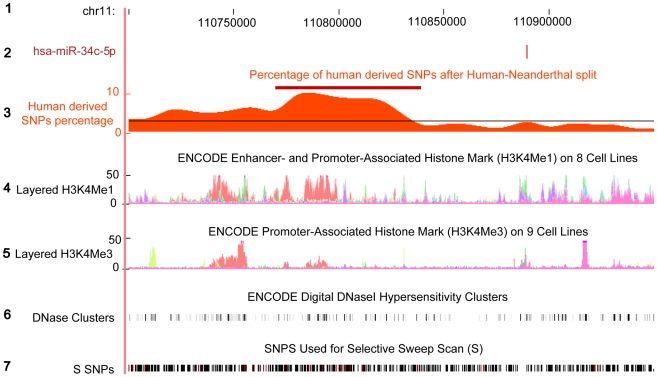
Excess of human derived SNPs in the upstream region of hsa-miR-34c.The plot shows 150kb region upstream of human miR-34c. The region annotation, from top to bottom: (1) The human genome coordinates based on hg18; (2) The genomic location of miR-34c-5p miRNA; (3) The percentage of human derived SNPs out of all SNPs calculated within 50kb sliding windows. The red bar shows the sliding windows with the significant excess of human derived SNPs, compared to the genome average (Fisher's exact test, Bonferroni corrected p<0.05). The average genome percentage is depicted by the black line (Materials and Methods); (4) H3K4Me1 histone modification density in eight cell lines from ENCODE database [66]. Presence of this histone mark indicates enhancer and, to a lesser extent, promoter activity [67]; (5) H3K4Me3 histone modification density in nine cell lines from ENCODE database [66]. Presence of this histone mark is associated with promoters [67]. Note that the genomic region showing the highest density of human derived SNPs overlaps with enhancer activity, but not with the promoter histone modification mark; (6) DNase Hypersensitivity Clusters from ENCODE database [66]. Regulatory regions tend to have higher DNase sensitivity [68]; (7) SNPs used in a genome-wide scan for signals of positive selection in the human lineage since divergence from the Neanderthal lineage [40]. Human derived SNPs are shown in red.